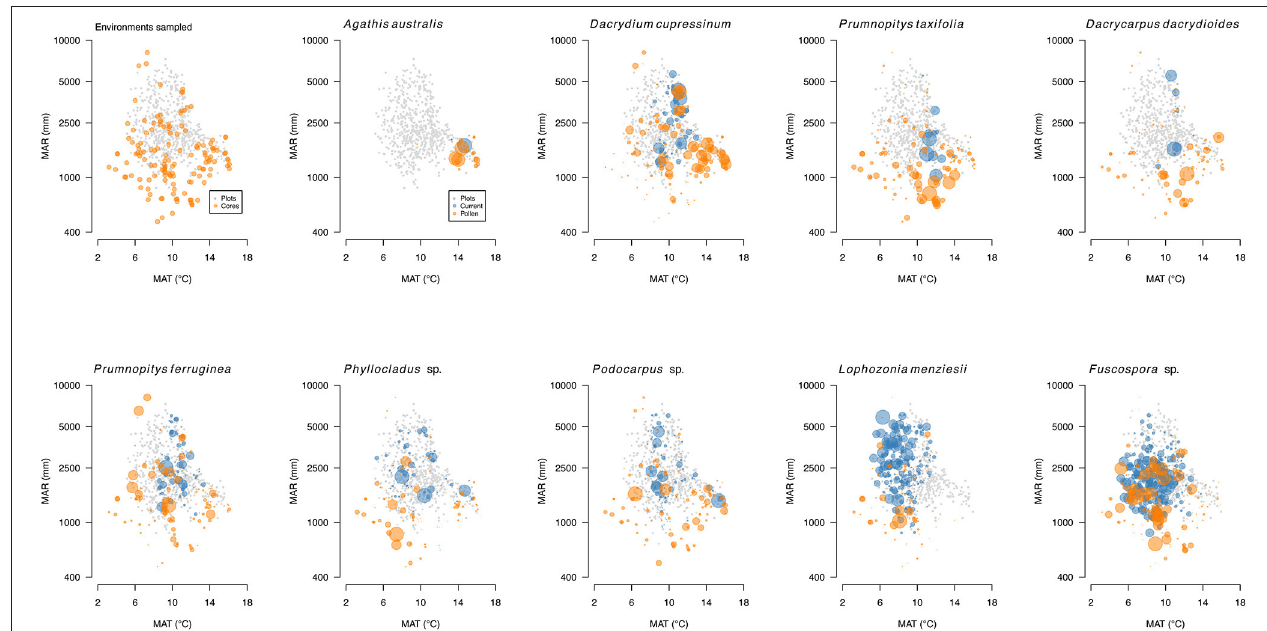
FIGURE 11 | Pollen (orange) and basal area biplots (gray) for conifers and Nothofagaceae. Pollen percentages (orange) based on terrestrial sum excluding ferns and lycopods. Basal areas for trees (blue) from the LUCAS programme national Natural Forest plot (20 × 20m) data. Data on individual panels scaled relative to largest